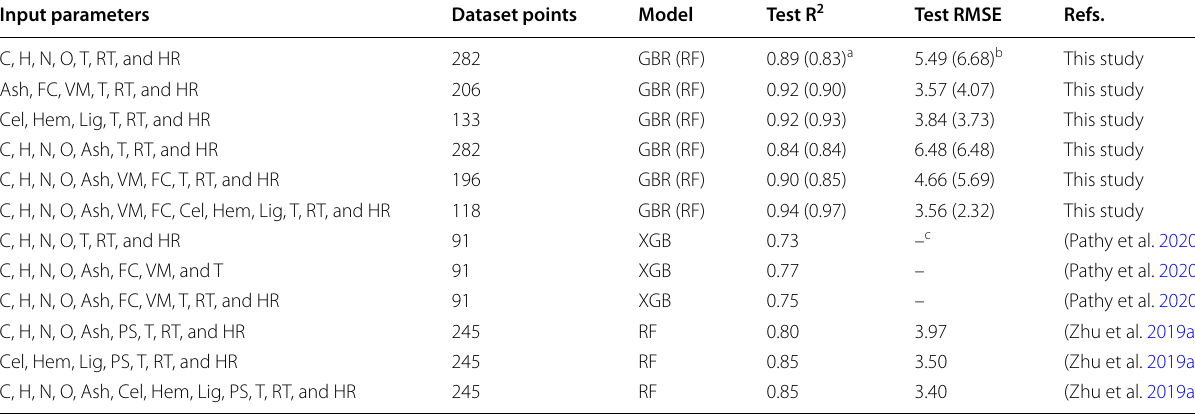
Table 2 Comparison of predictive performance for biochar yield in this study and in previous